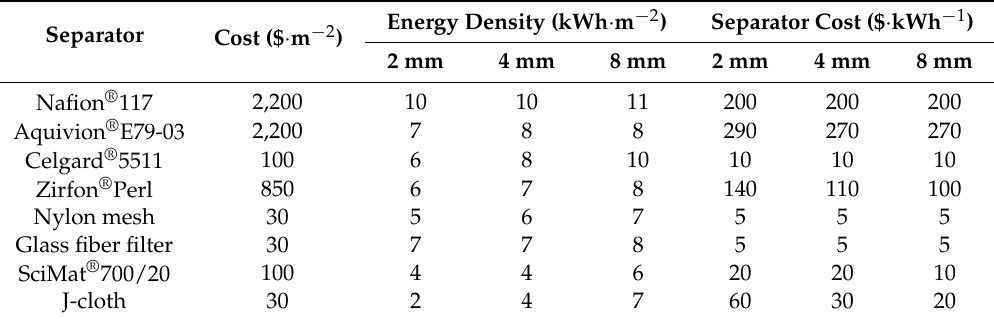
Table 5. Cost of the separator and energy density over 5 years (estimated based on: interest rate